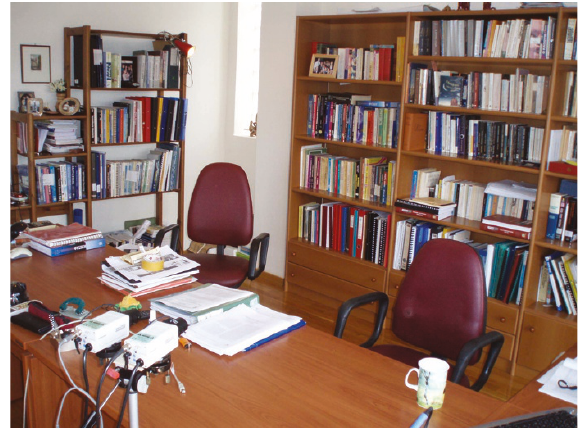
Figure 22: Panoramic view of the o ffi ce premises where the mapping experiment was